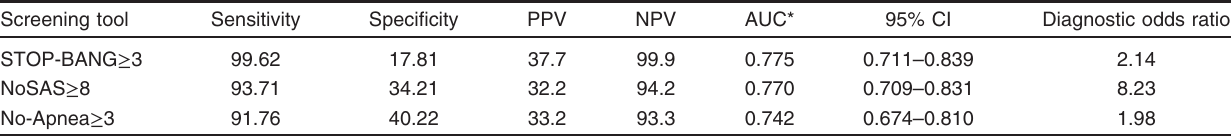
Table 2 Performance parameters of the studied scores as screening tools for clinically significant sleep-disordered breathing (apnea – hypopnea index ≥ 20/h) Screening tool